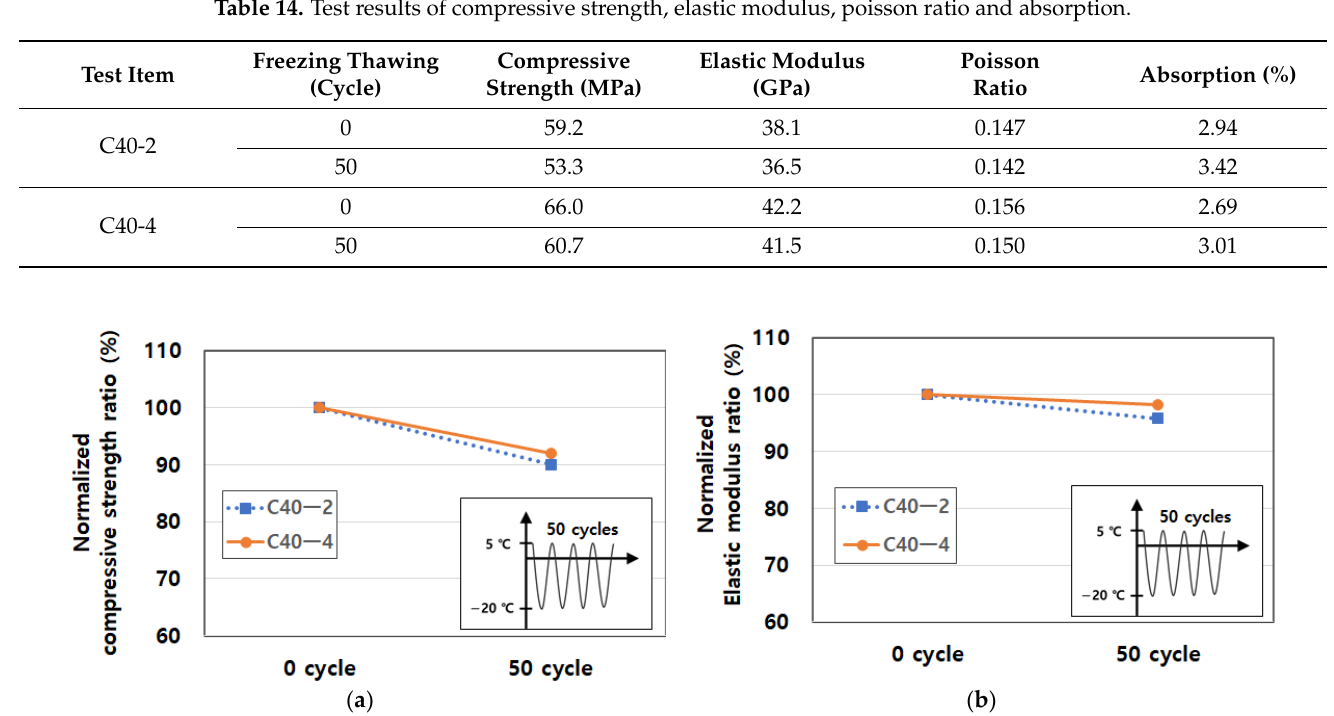
Figure 12. Normalized mechanical properties exposed to cyclic low temperature: ( a ) normalized compressive strength over F-T cycles and ( b ) normalized elastic modulus over F-T cycles.